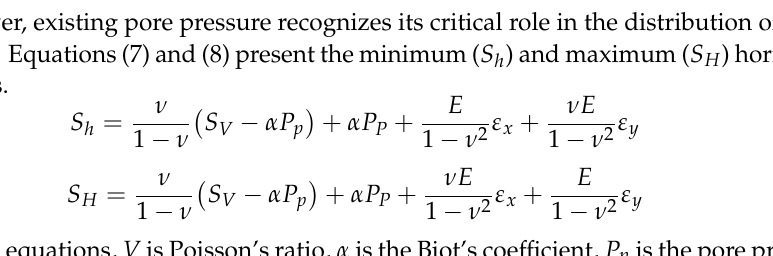
Figure 12. Variations of vertical stress vs. the depth of wellbore-D in the Azar oilfield.